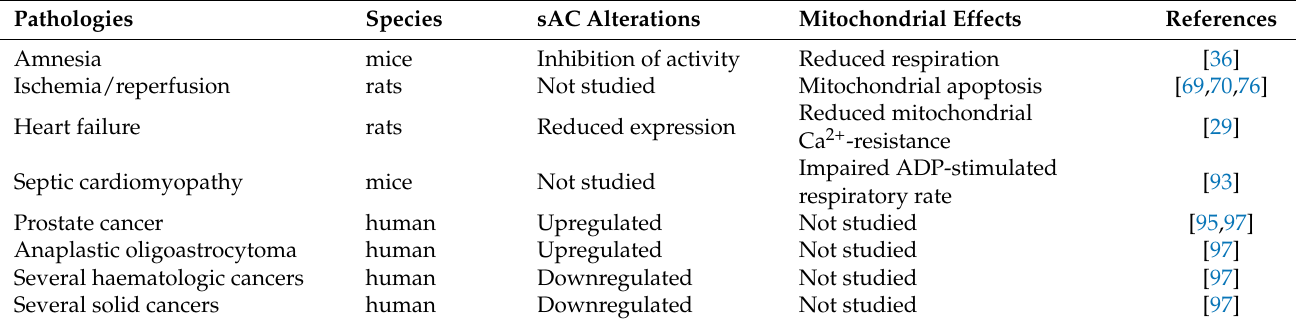
Table 1. A brief overview of pathologies associated with dysregulation of mitochondrial sAC-signalling.